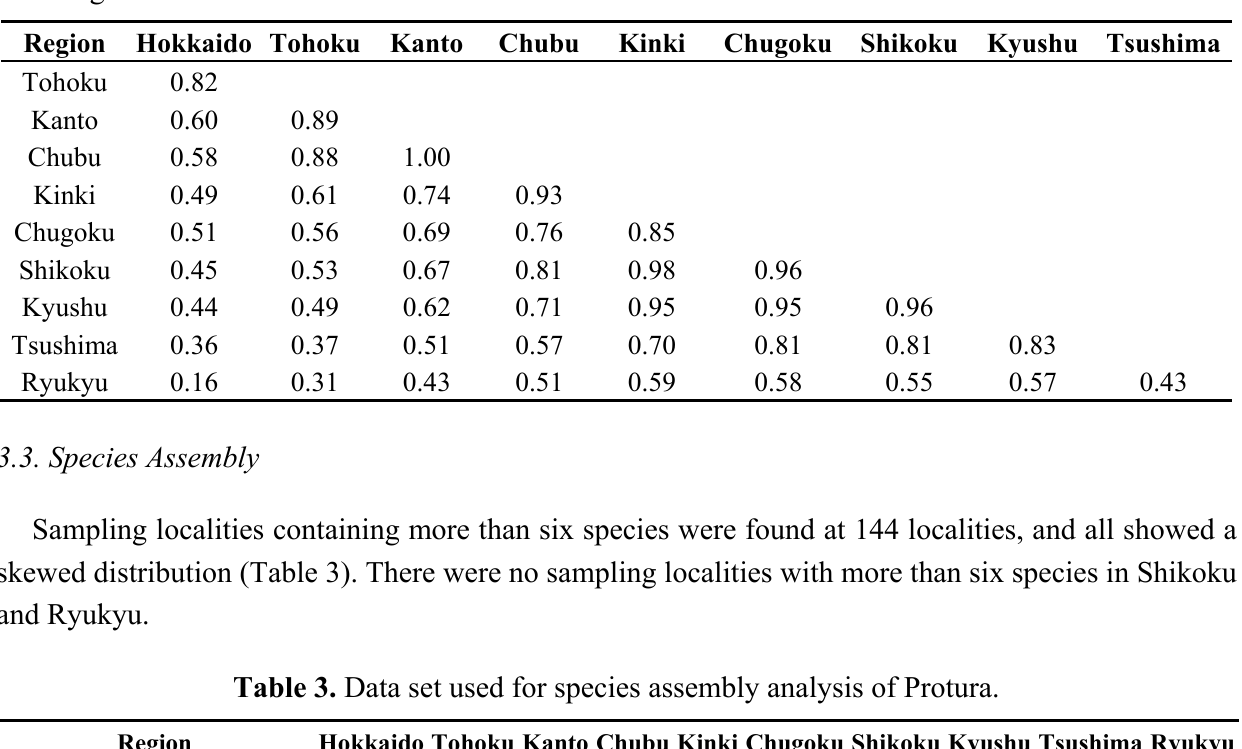
Table 2. Species composition similarity (Modified Jaccard index [67]) matrix between the regional localities.